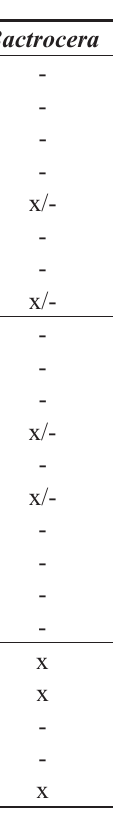
Table 2. Sexual behaviors observed in males of Ceratitis capitata (Ceratitidini), Anoplomus rufipes (Gastrozonini) and Bactrocera spp. (Dacini). Information stems from sources cited in the text. Abbreviations for the different types of signals: P = pheromone, S = sound, V = visual stimulus, T = tactile